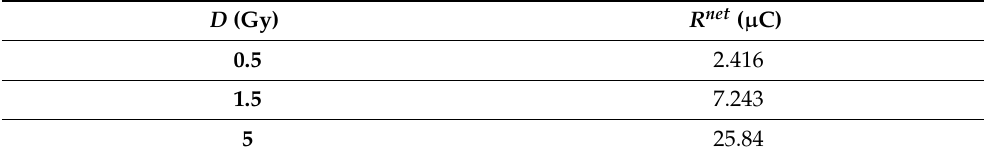
Table 3. Measured net values for each dose point when TLDs were exposed to Cobalt-60. Relative uncertainties on 𝑅 (cid:3041)(cid:3032)(cid:3047) are expressed in Table 4. Table 1. Measured net values for each dose point when TLDs were exposed to 250 kV and 1 mm Cu added filtration X-rays spectrum. Relative uncertainties on R net are expressed in Table 4.